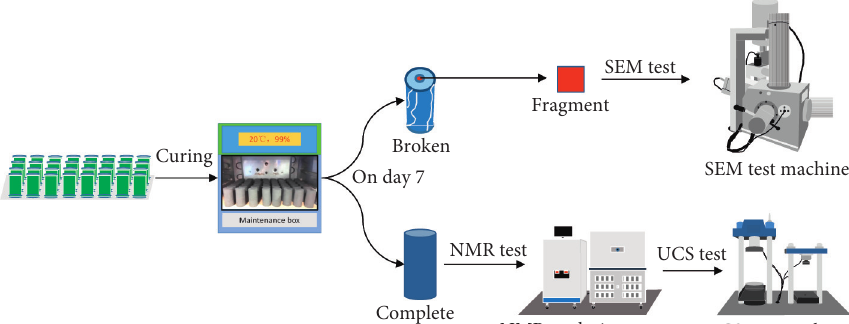
Figure 3: Experiment process with sample preparation, UCS tests, and SEM.